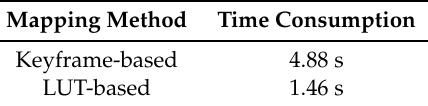
Table 5. Average time consumption.